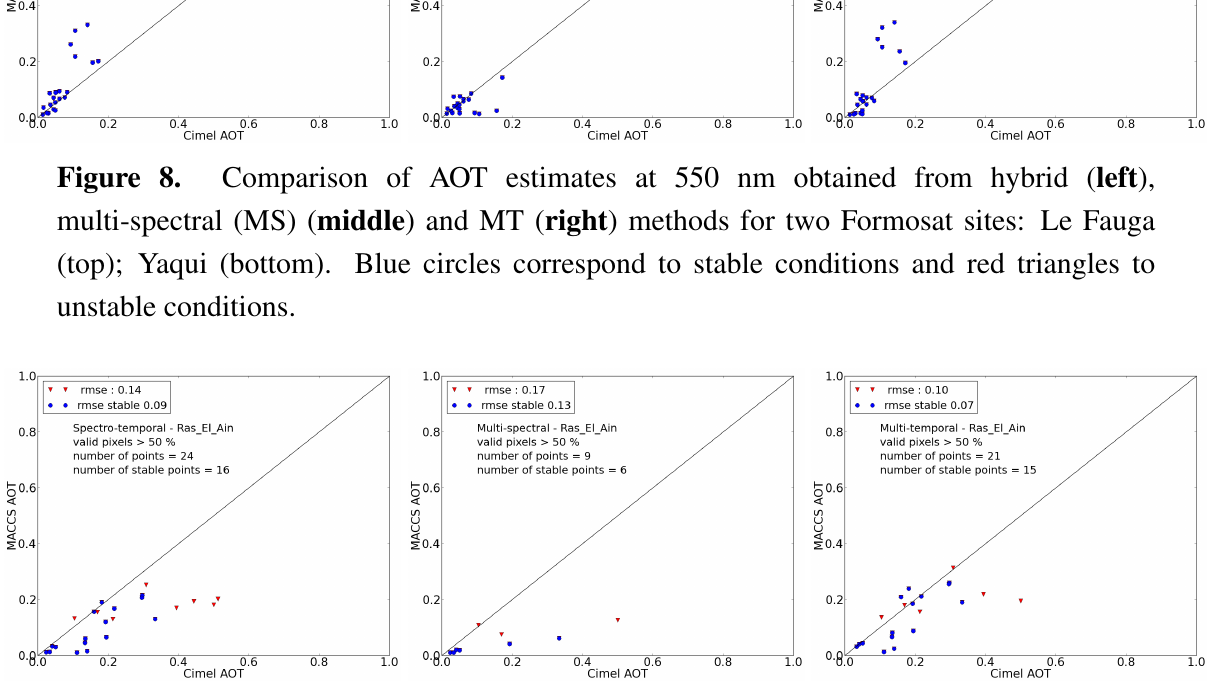
Figure 9. Comparison of AOT estimates at 550 nm obtained from hybrid ( left ), MS ( middle ) and MT ( right ) methods for the Formosat site in Ras El Ain (Morocco). Blue circles correspond to stable conditions and red triangles to unstable